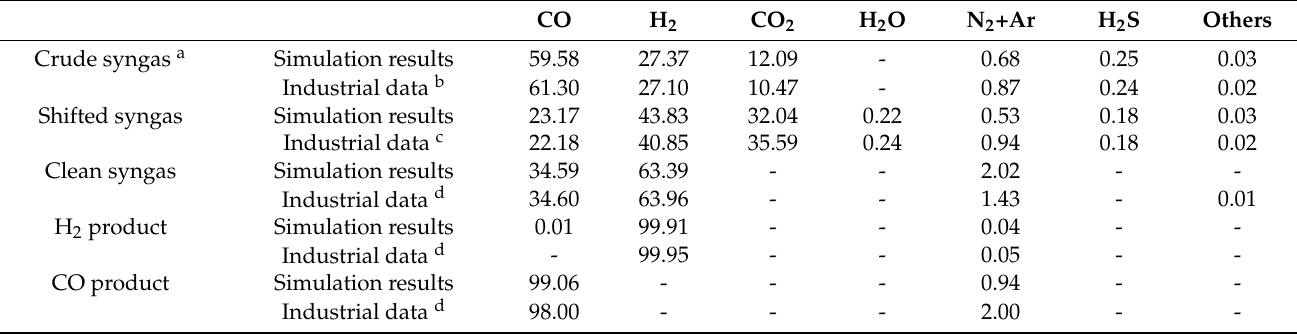
Table 3. Comparison of the simulation and reported results of key streams.